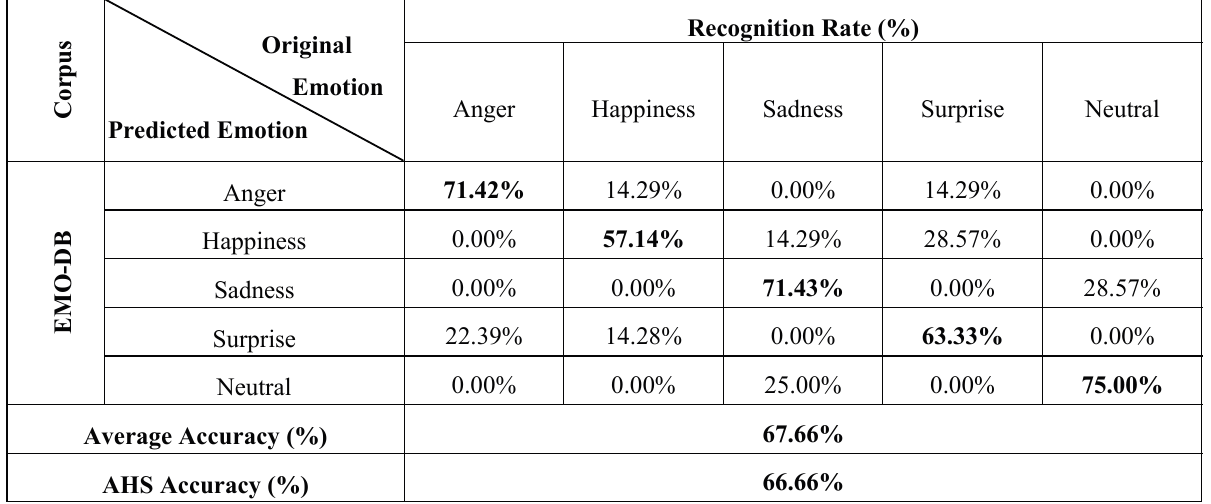
Table 11. Evaluation of ESS proposed by Ashish using MFCC feature with SVM classifier. pu r o C